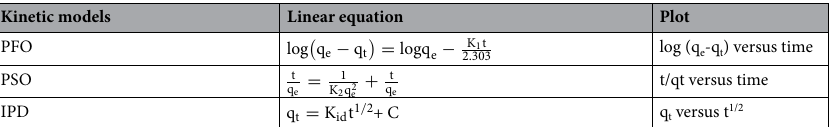
Kinetic models Linear equation Plot